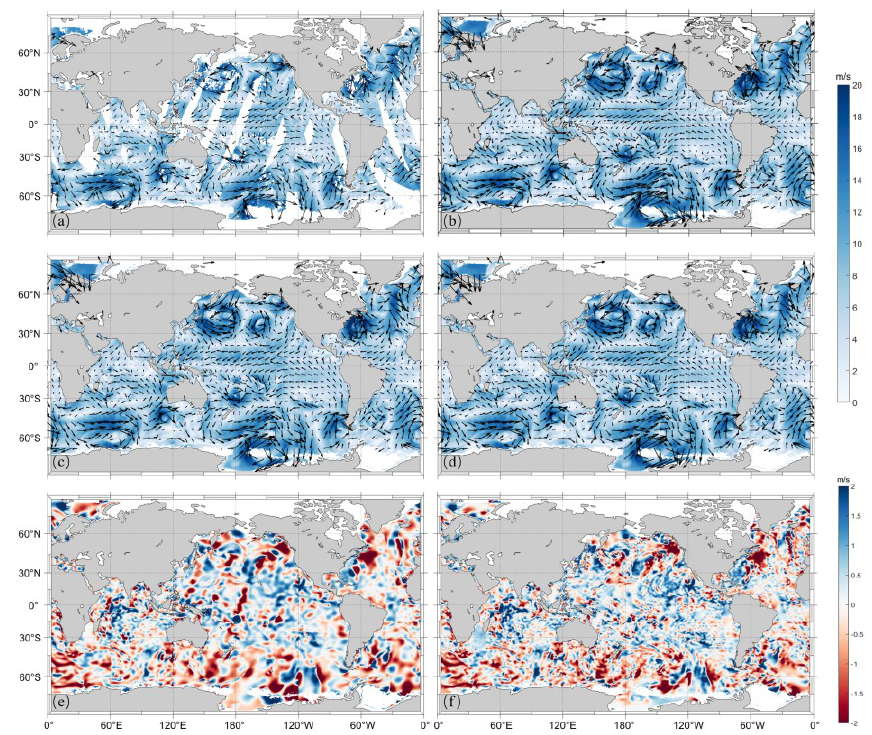
Figure 5. ( a ) HSCATs wind fields on 15 January 2022 at UTC 00:00 ± 3 h; ( b ) ERA5 background wind field on 15 January 2022 at UTC 00:00; ( c ) the 2D-Var analysis wind field based on the GSF; ( e ) the wind speed difference between ( b , c ); ( d , f ) are similar to ( c , e ), but for the 2D-Var analysis with EBEC. Color bars indicate the wind